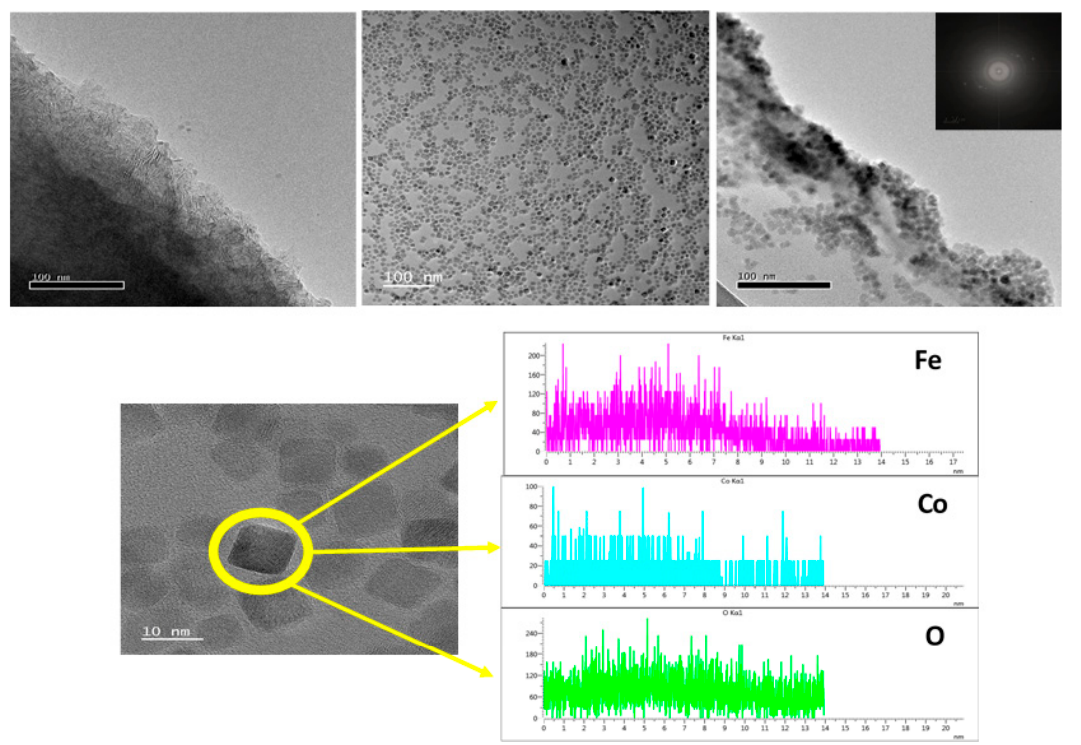
Figure1. TransmissionElectronMicroscopy (TEM)imagesofthe( a )WS 2 sheets, ( b )s-CoFe 2 O 4 @c-Fe 3 O 4 NPs and ( c ) WS 2 / s-CoFe 2 O 4 @c-Fe 3 O 4 nanocomposites shows the layered structure of WS 2 and